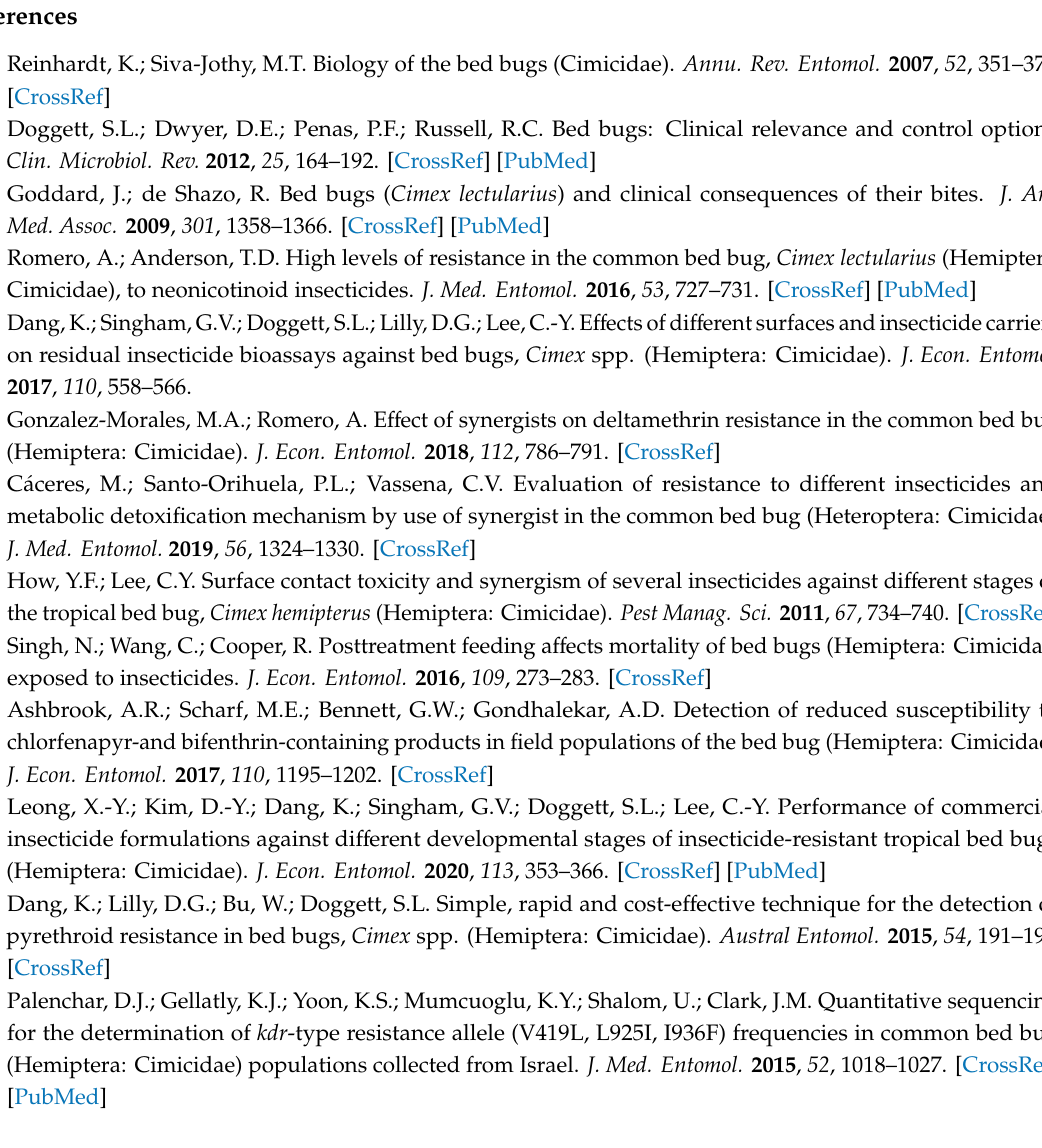
Table S1: Percentage mortality of a susceptible C. lectularius strain and three C. hemipterus strains exposed to Tandem, Temprid SC, Pesguard FG161, Sumithrin, and Sumithion at label rate. Table S2: Percentage mortality of a susceptible C. lectularius strain and three C. hemipterus strains exposed to Phantom at label